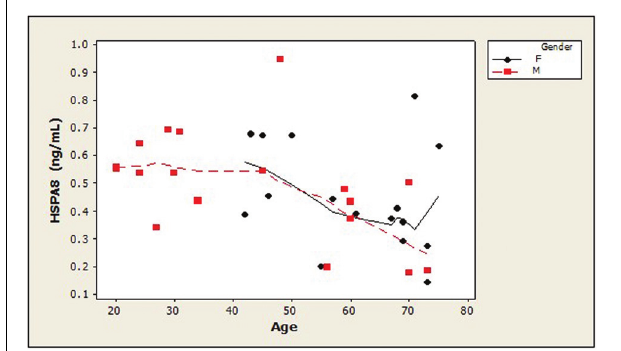
subject age (Spearman’s ρ = − 0.47; p = 0.005). LOWESS curves (dashed lines, men; solid lines, women) suggested that HSPA8 may decrease